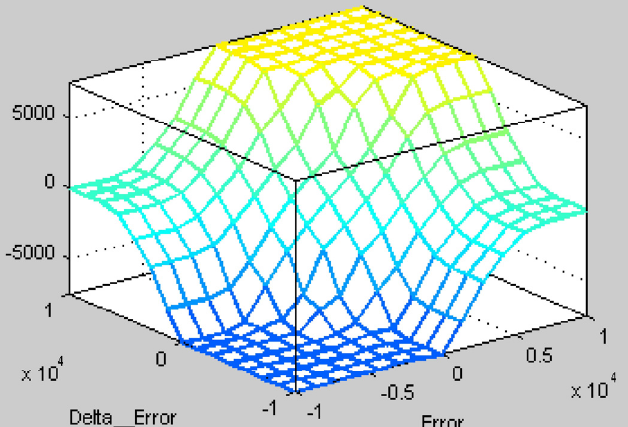
FigureA4. Surface.